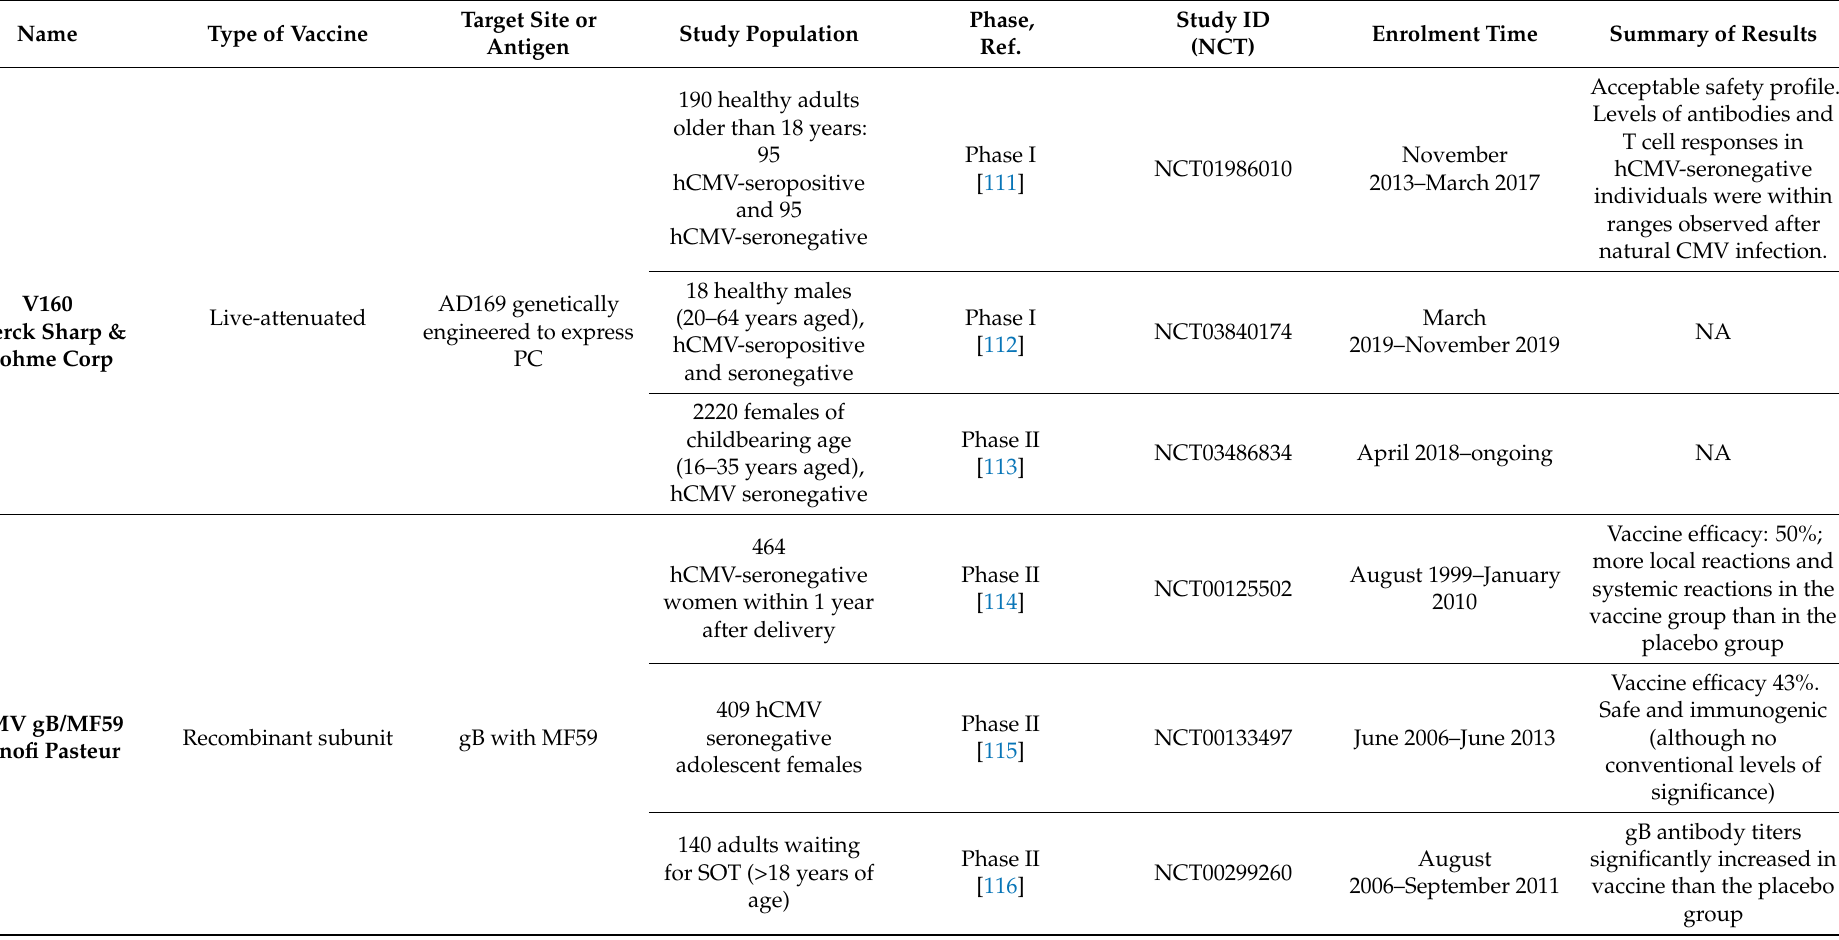
Table 1. Overview of the CMV vaccines under clinical development. PC: pentameric complex; NA: not available; gB: glycoprotein B; SOT: solid organ transplant; HSCT: